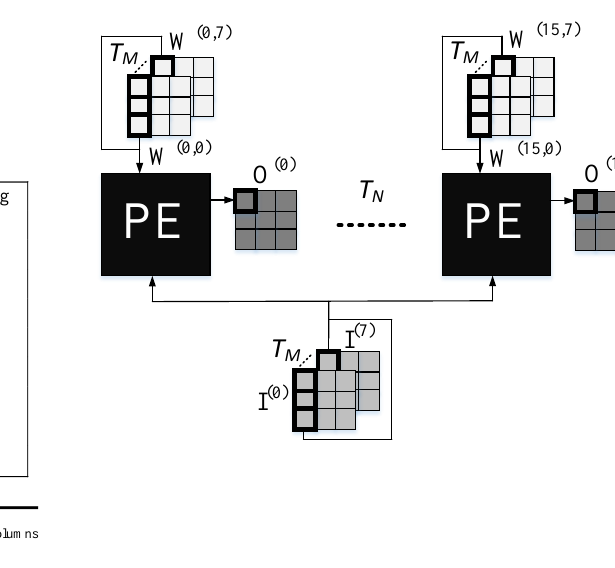
Figure 3. Loop unrolling and parallel